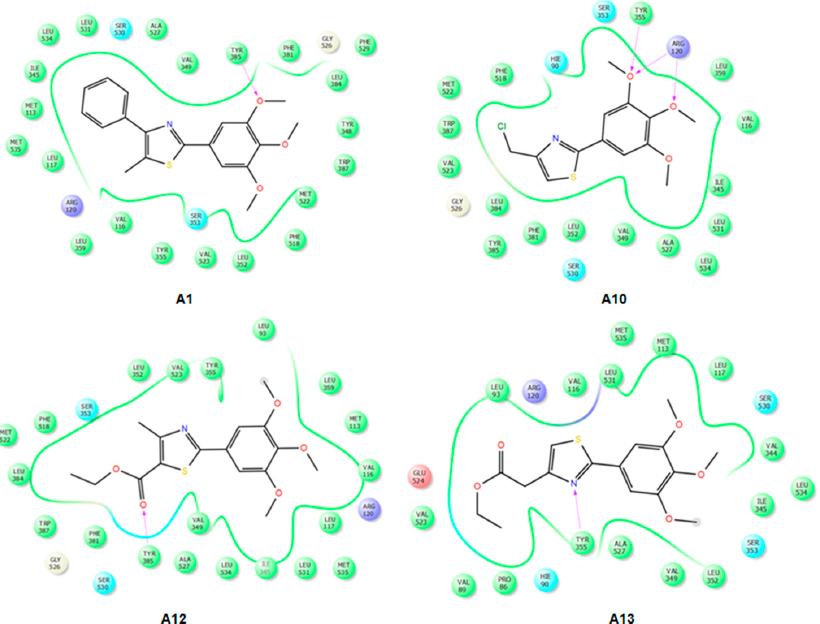
Figure 7. 2D projections of the interactions of compounds A1 , A10 , A12 and A13 with the active site of COX-2 (4M11).